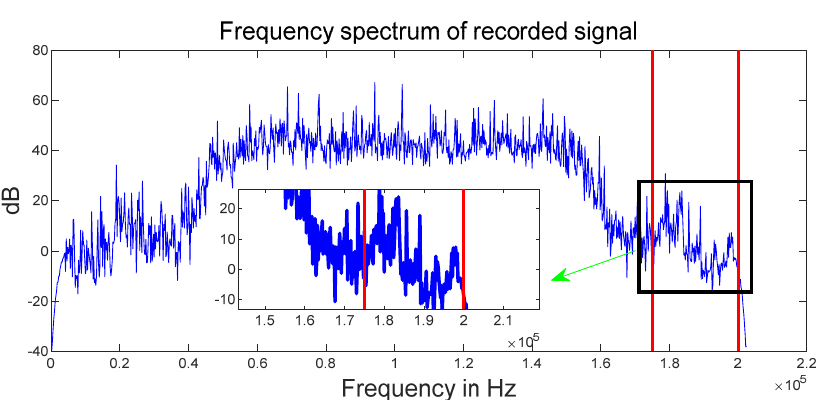
Figure 3. Spectrum analysis of in vivo Y85a transmit and MEIZU 16 s Pro receive signals.